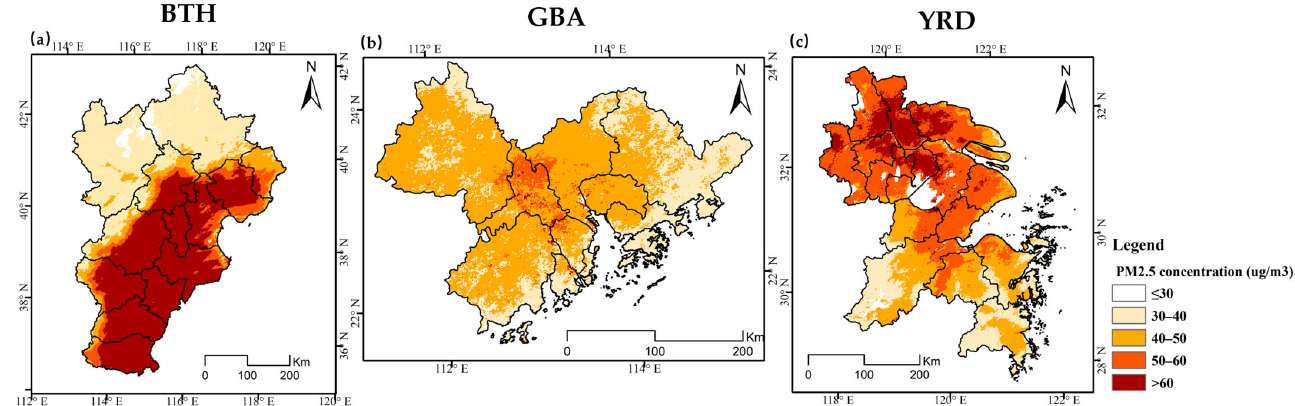
Figure 7. Spatial stratification of the thermal environmental situations in the three UAs: ( a ) BTH, ( b ) GBA, and ( c ) YRD.